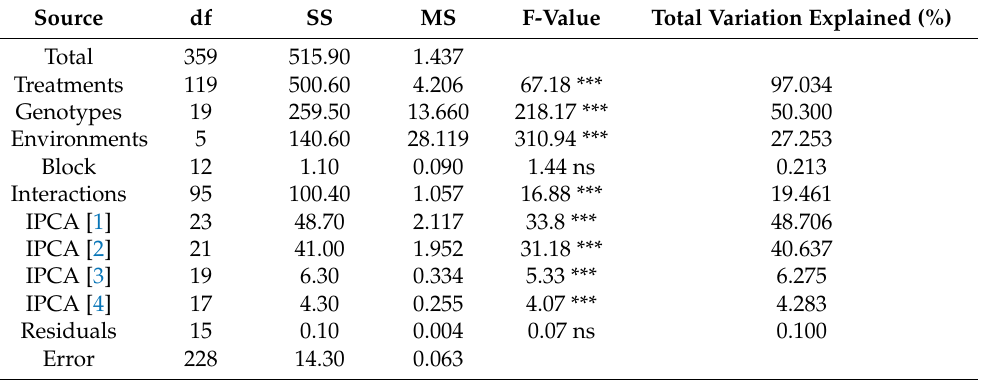
Table 5. AMMI analysis of variance for grain yield among 20 genotypes across six test